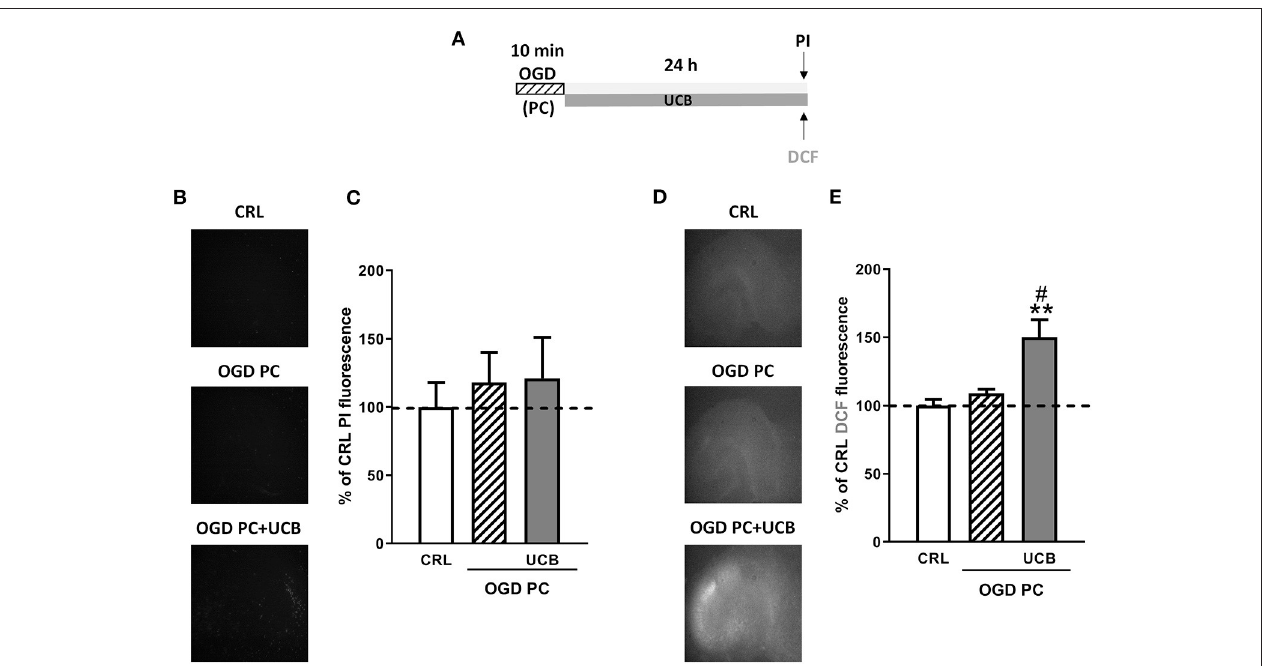
FIGURE 5 | Effect of OGD-preconditioning and UCB in immature organotypic hippocampal slices. (A) Experimental protocol showing immature hippocampal slices subjected to 10min OGD (preconditioning) and then to UCB (100 µ M) for 24h. (B) Qualitative analysis shows that OGD- preconditioning and UCB did not induce neuronal death. (C) Quantitative analysis is expressed as percentage of control (CRL) PI fluorescence. (D) Qualitative analysis shows that the addition of UCB on OGD PC induces cellular oxidative stress. (E) Quantitative analysis of DCFH2-DA fluorescence: Bars represent the mean ± SEM of at least seven experiments (about ≥ 28 slices for each experimental point). ** P < 0.01 vs. CRL; # P < 0.05 vs.